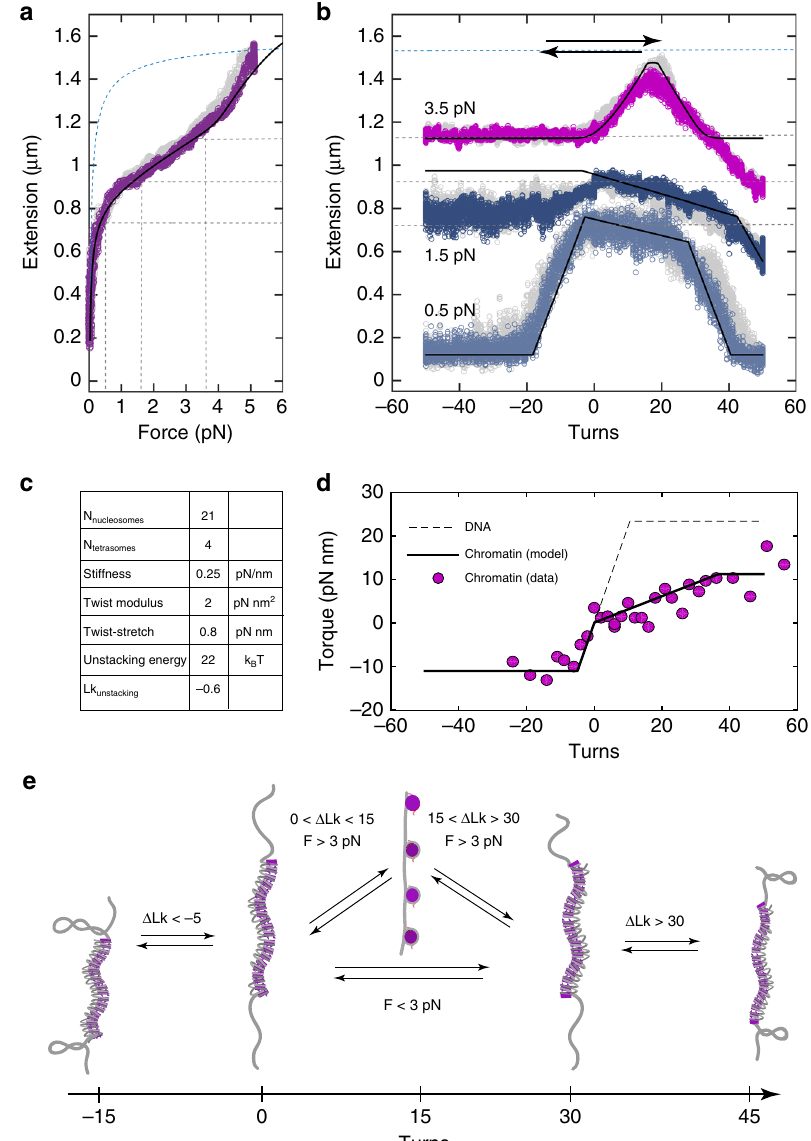
Fig. 4 197-NRL fi bers adopt a left-handed, one-start structure with similar torsional response. a Force-extension curve of a rotationally constrained 25 (cid:3) 197 chromatin fi ber. The initially compacted fi ber is stretched under force (violet) and observed to unstack at 4.5 pN. When the force is subsequently decreased, the fi ber is observed to refold to its initial con fi guration (grey). The solid black line re fl ects the best fi t to the statistical mechanics model with: N ¼ 21 ; N ¼ 4, unstacking energy G = 22 k T and stretching stiffness per nucleosome c ¼ 0 : 25 pN (cid:3) nm (cid:1) 1 . The dashed blue line re fl ects s nucleosomes tetrasomes u B the extension of a DNA template with singly wrapped nucleosomes. The dashed black lines mark the forces and extensions examined during the subsequent rotation experiment. b Rotation-extension curves of the same molecule as in panel a at forces of 0.5 pN (blue), 1.5 pN (dark grey) and 3.5 pN (pink). Grey curves re fl ect the measurements with a reversed direction of magnet rotation. Solid black lines re fl ect the torsional spring model using the parameters as in panel a together with a torsional stiffness c t ¼ 2 ± 1 pN (cid:3) nm 2 and twist-stretch coupling factor c ts ¼ 0.8 pN (cid:3) nm. c Table summarizing the parameters used in the quanti fi cation of curves in panels a and b . d Representative torque-twist measurement on a 197-NRL chromatin fi ber at 2 pN (violet). Data were offset to equate the torque plateau at negative twist with the DNA melting torque of -10 pN (cid:3) nm. The dotted grey line represents the predicted torque build-up in the DNA handles alone. The solid black line shows the restoring torque of the chromatin tether quanti fi ed with a torsional spring model yielding a torsional stiffness c t ¼ 2 pN (cid:3) nm 2 . e Schematic summarizing the structural changes in a chromatin tether under torsion. Torsionally relaxed 197-NRL fi ber (twist = 0) cannot absorb negative turns, and as such the entire linking number change is absorbed by the DNA handles. The consequences of imposed positive twist depend on the level of tension and may involve unstacking of nucleosomes in the chromatin fi ber followed by changes in its chirality. This delays the formation of DNA plectonemes compared to negative